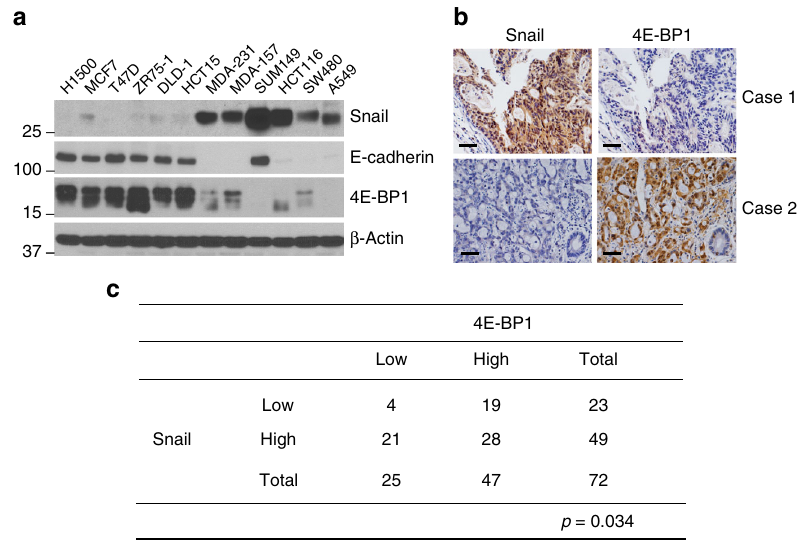
Fig. 1 4E-BP1 expression inversely correlates with Snail expression in cancer. a Cell lysates were prepared from the indicated cancer cell lines and analyzed by western blotting for the indicated proteins. b , c A tissue array of 72 human colorectal cancer specimens was subjected to immunohistochemical staining using antibodies against Snail ( b , left) and 4E-BP1 ( b , right). The immunoreactivity was scored blindly according to the value of immunoreaction intensity (none = 0; weak = 1; intermediate = 2; and strong = 3) and the percentage of tumor cell staining (none = 0; < 10 = 1; 10 – 50 = 2; > 50% = 3). The intensity and percentage values were added to provide a fi nal immunoreactivity score ranging from 0 to 6. A score from 0 to 4 was de fi ned as low protein expression and a score of 5 – 6 indicates a high level of protein expression. Representative staining images are shown in b and the immunoreactivity scores of the 72 specimens are summarized in a grid c that associates expression for both Snail and 4E-BP1. Statistical signi fi cance of the correlation between Snail and 4E-BP1 expression was determine by the χ 2 -test with the p -value indicated. Scale bar, 50 µ